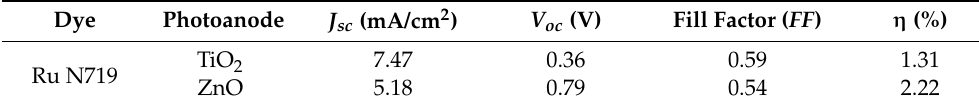
Table 1. Electrical performance for the TiO 2 and ZnO Baseline Cell with Ru N719 dye. Dye Photoanode J sc (mA/cm 2 )